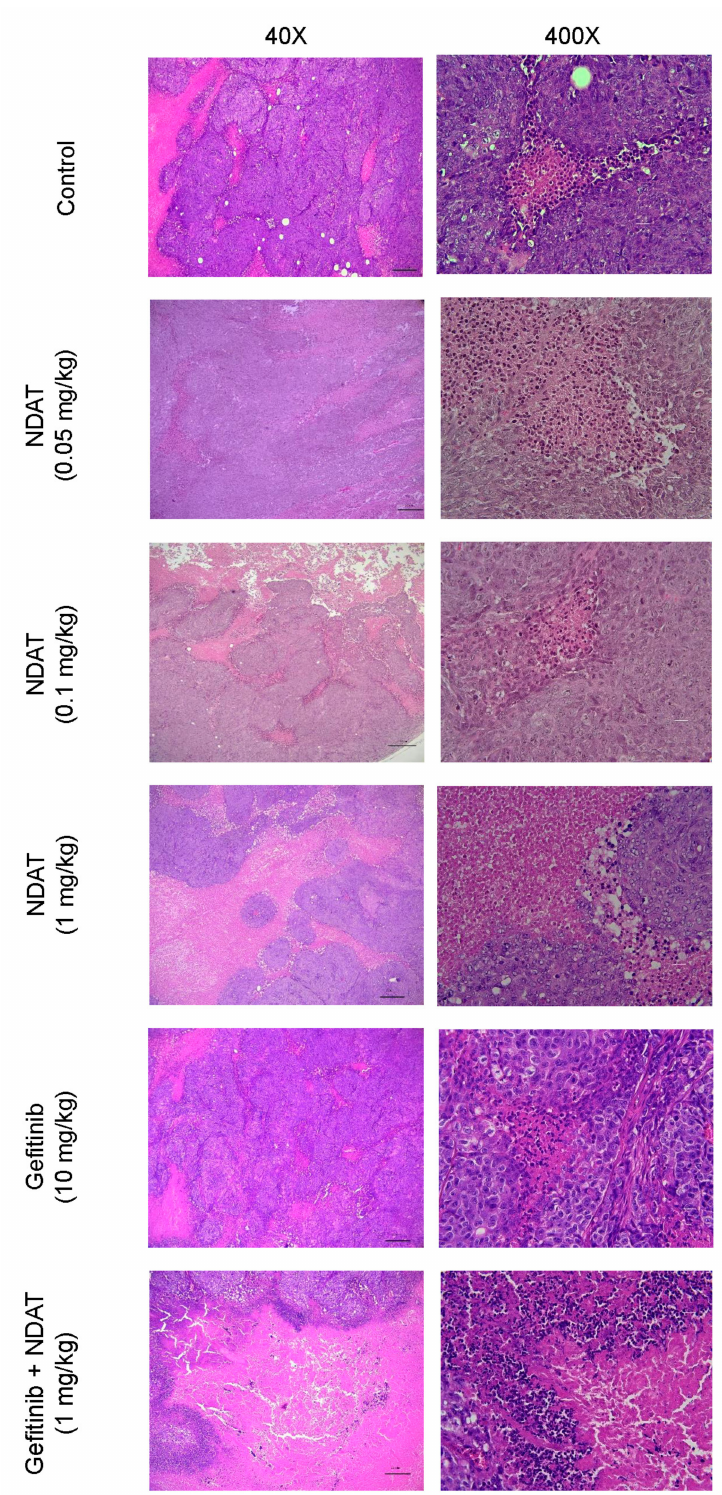
Figure 6. H&E stain of HCT116 xenograft tumor tissues. Xenograft tissues from various treatment including NDAT (0.05 mg, 0.1 mg, 1 mg / kg), gefitinib (10 mg / kg) or combined treatment were stained by hematoxylin (nucleus, blue) and eosin (extracellular matrix and cytoplasm, pink). The magnification is 40 × (left panels, bar = 210 µ m) and 400 × (right panels, bar = 21 µ